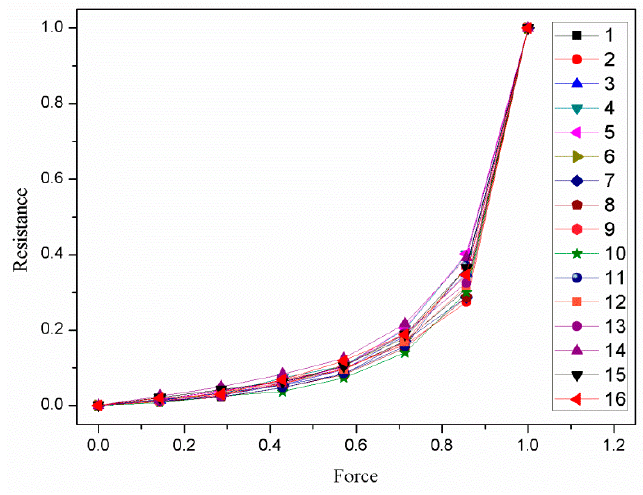
Figure 14. The normalized sample data.